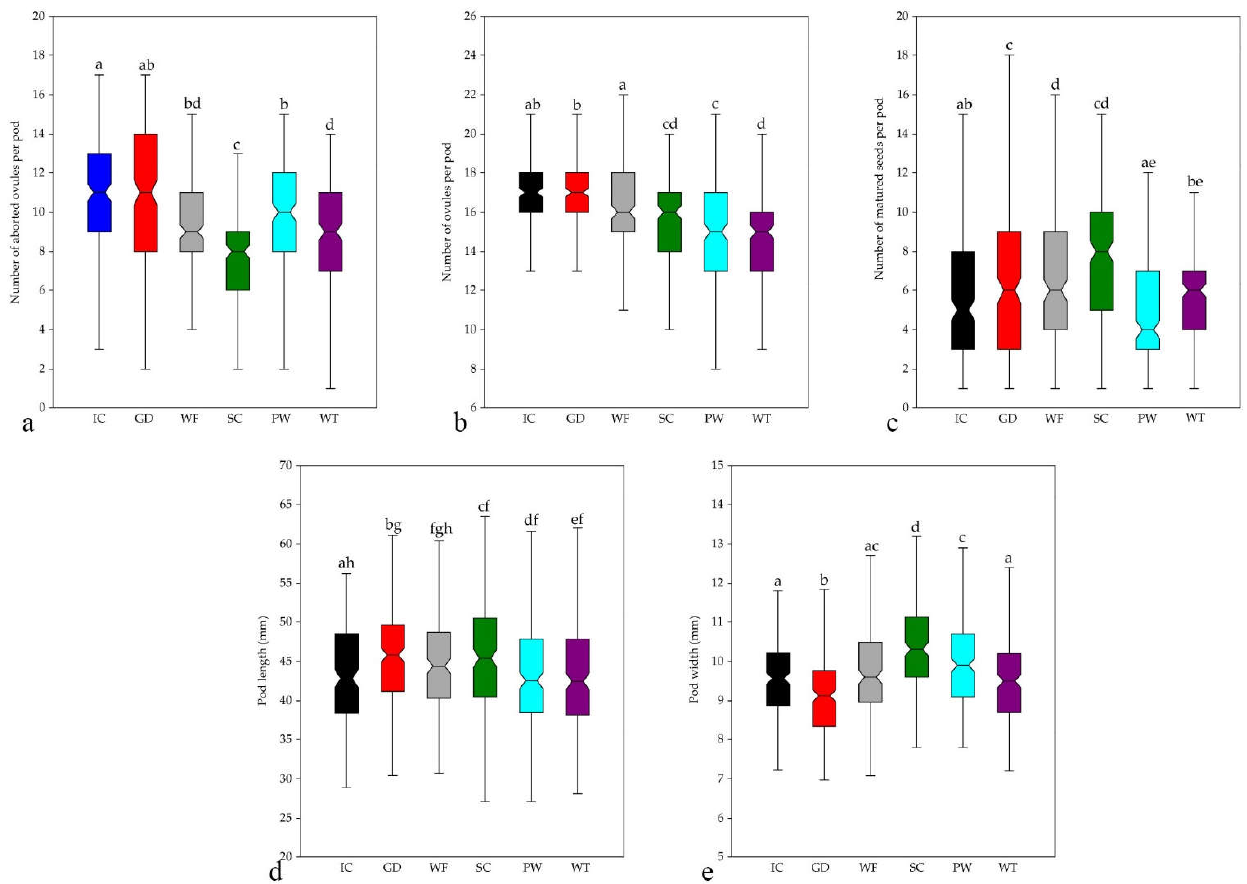
Figure 4. Comparison of the reproductive traits of Cytisus scoparius in the sites grouped by habitat type (n = 200 in each). different habitat types by the number of ovules per pod ( a ), number of matured seeds ( b ), number of aborted ovules ( c ), pod length ( d ), and pod width ( e ). Abbreviations of the habitat types: IC—inland cliffs, DG—grey dunes, WF—woodland fringes, SC—shrubby clearings, PW—Scots pine woodlands, WE—western taiga. Different letters indicate statistically significant differences of the trait mean values between habitat types according to the Tukey’s post-hoc pairwise comparisons.